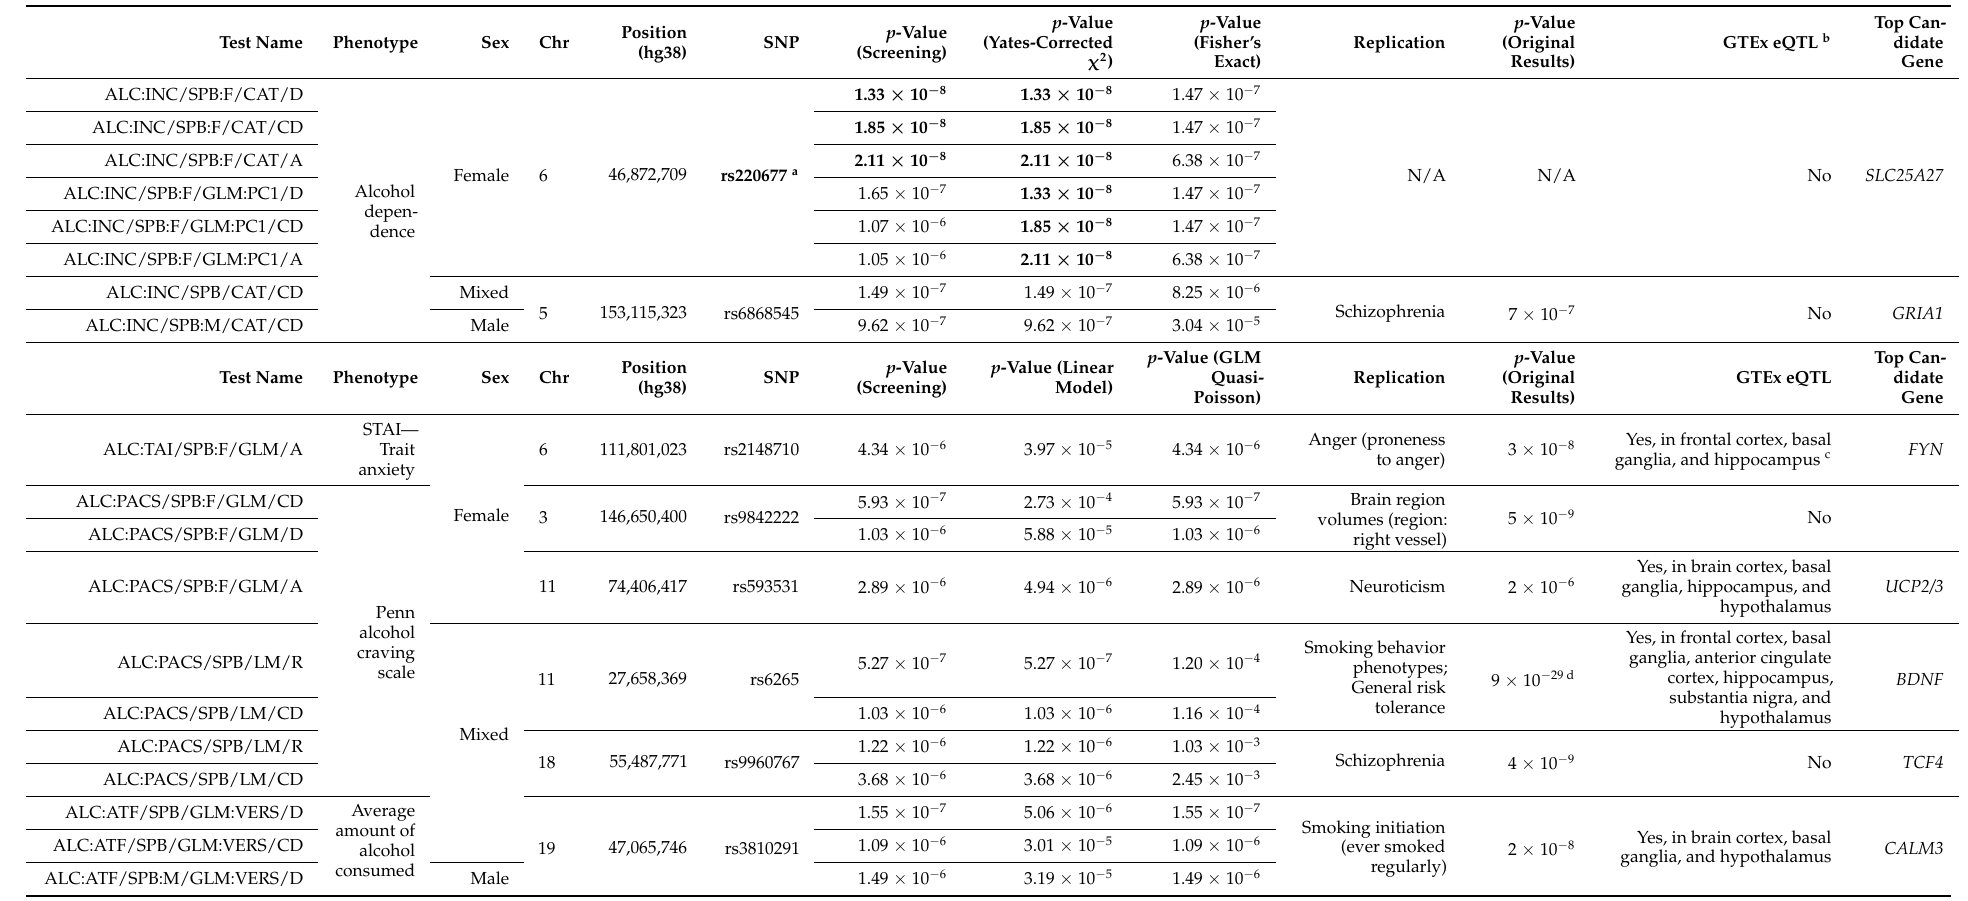
Table 3. GWAS top